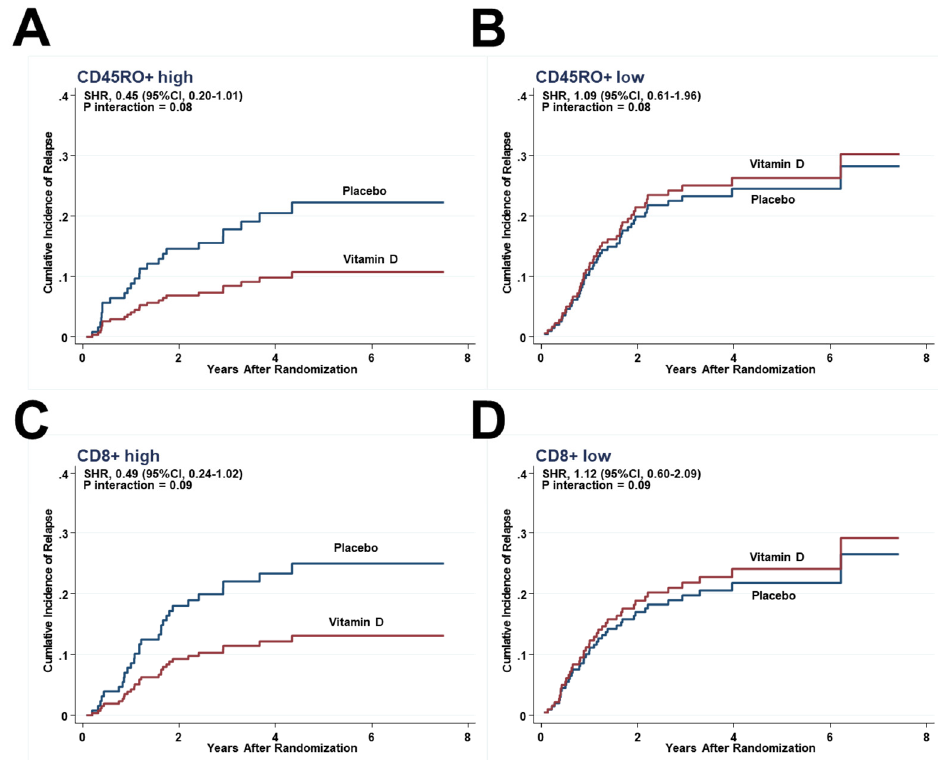
Figure 4. Effect of vitamin D on relapse by competing-risk analysis in the subgroups of ( A ) CD45RO+ higher half, and ( B ) CD45+ lower half, as well as ( C ) CD8+ higher half, and ( D ) CD8+ lower